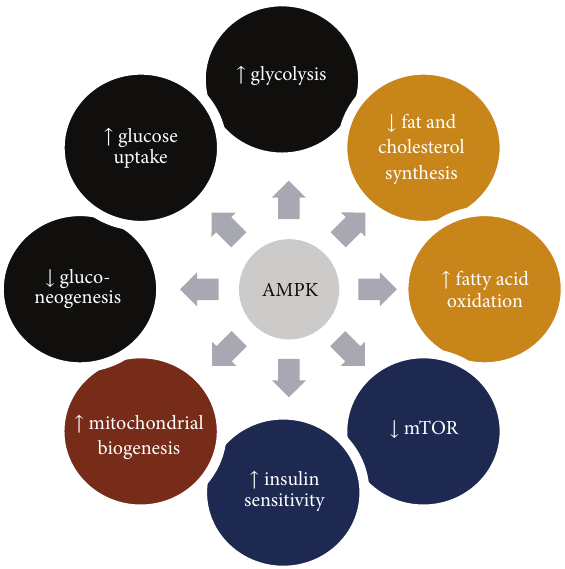
Figure 3: AMPK activation leads to multiple metabolic